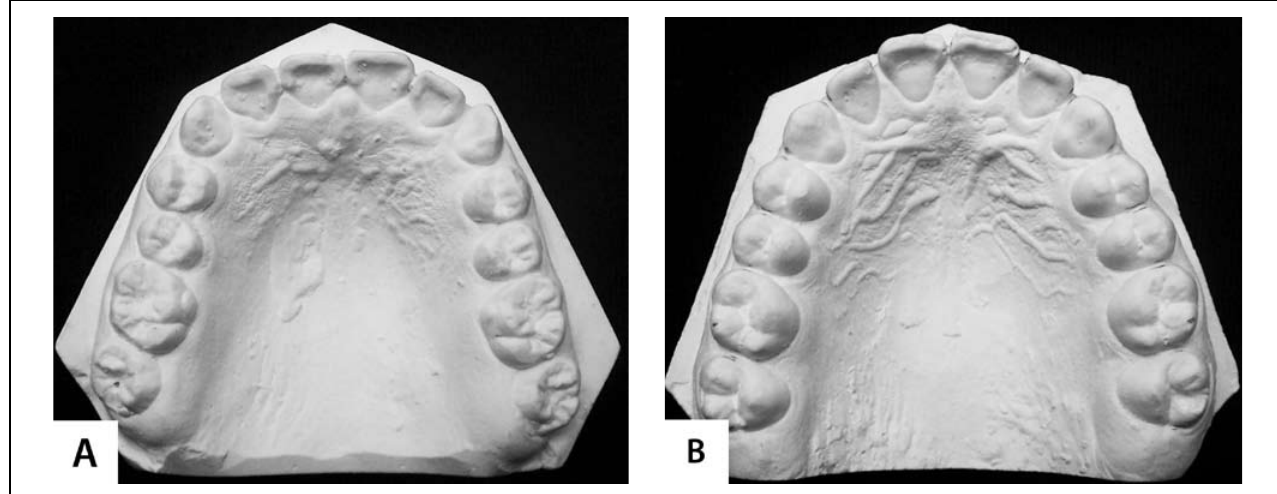
Figure 2. (A) Representative Mazahua dental arch and (B) representative Mestizo dental